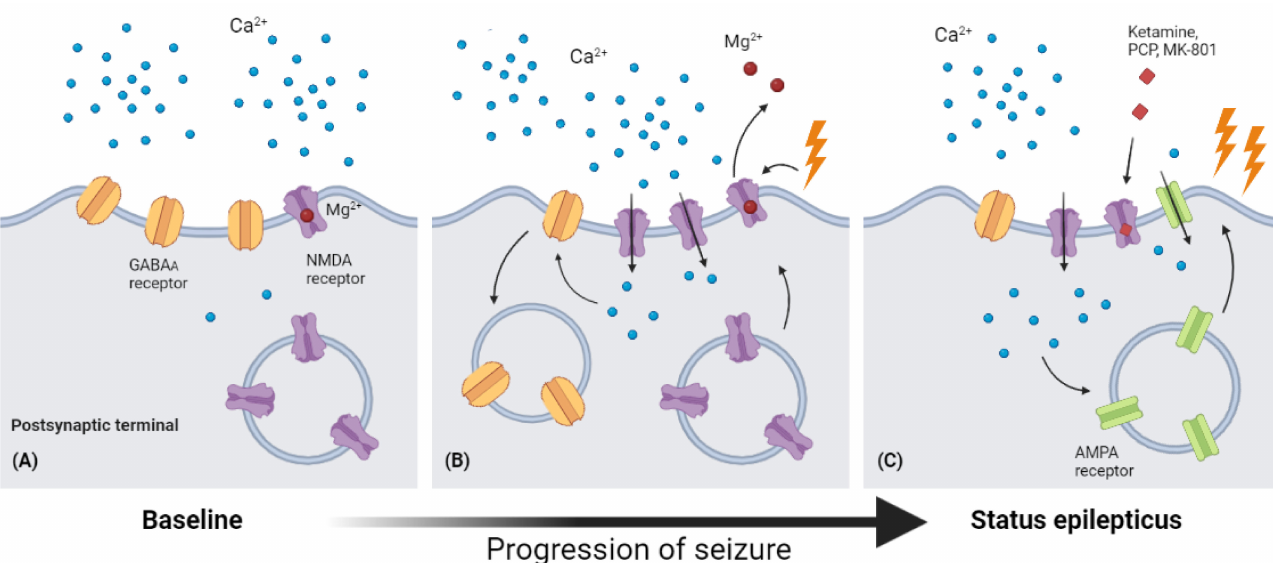
Figure 2. Receptor traffic and modulation during the process of SE. ( A ) In baseline conditions, Mg 2+ blocks the ion channel of the NMDA receptor, leading to low permeability of Ca 2+ . ( B ) As seizure occurs, the depolarization of the postsynaptic membrane would cause Mg 2+ to leave the binding site in the ion channel, leading to a significantly increased permeability of Ca 2+ . The surging intracellular Ca 2+ then causes endocytosis of GABAA receptors and up expression of NMDA receptors. ( C ) The increasing intracellular Ca 2+ level also enhances AMPA expression in the postsynaptic membrane, and this increased expression of NMDA and AMPA receptors may explain the increasing anticonvulsant effects of NMDA receptor antagonists (ketamine, PCP, MK-801) (Figure created with